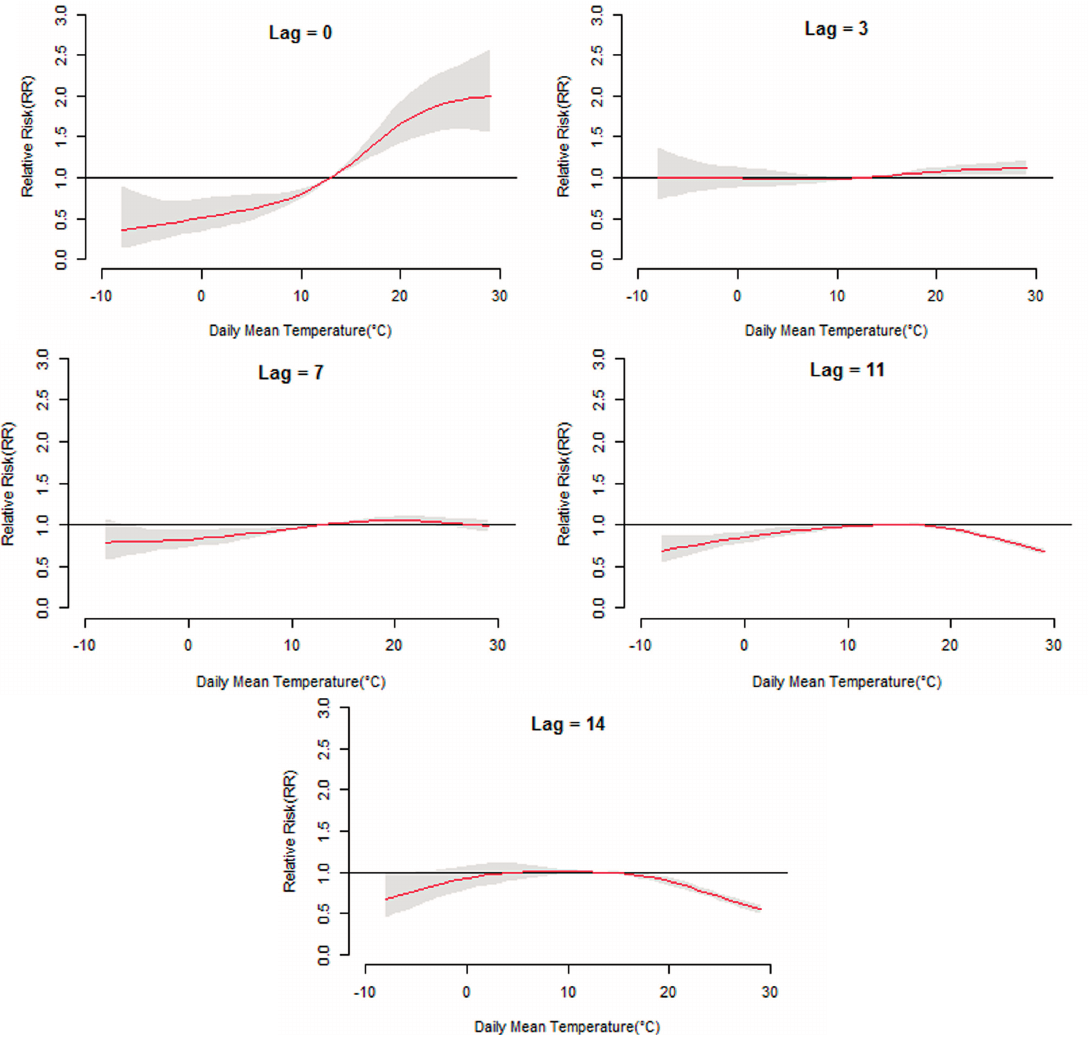
Figure 5. The relative risk of HFMD by daily mean temperature at a specific lag day (0, 3, 7, 11, and 14 days) in Qingdao. The maximum likelihood estimate of RRs is shown as smooth red lines and the pointwise 95% confidence intervals are shown in the gray